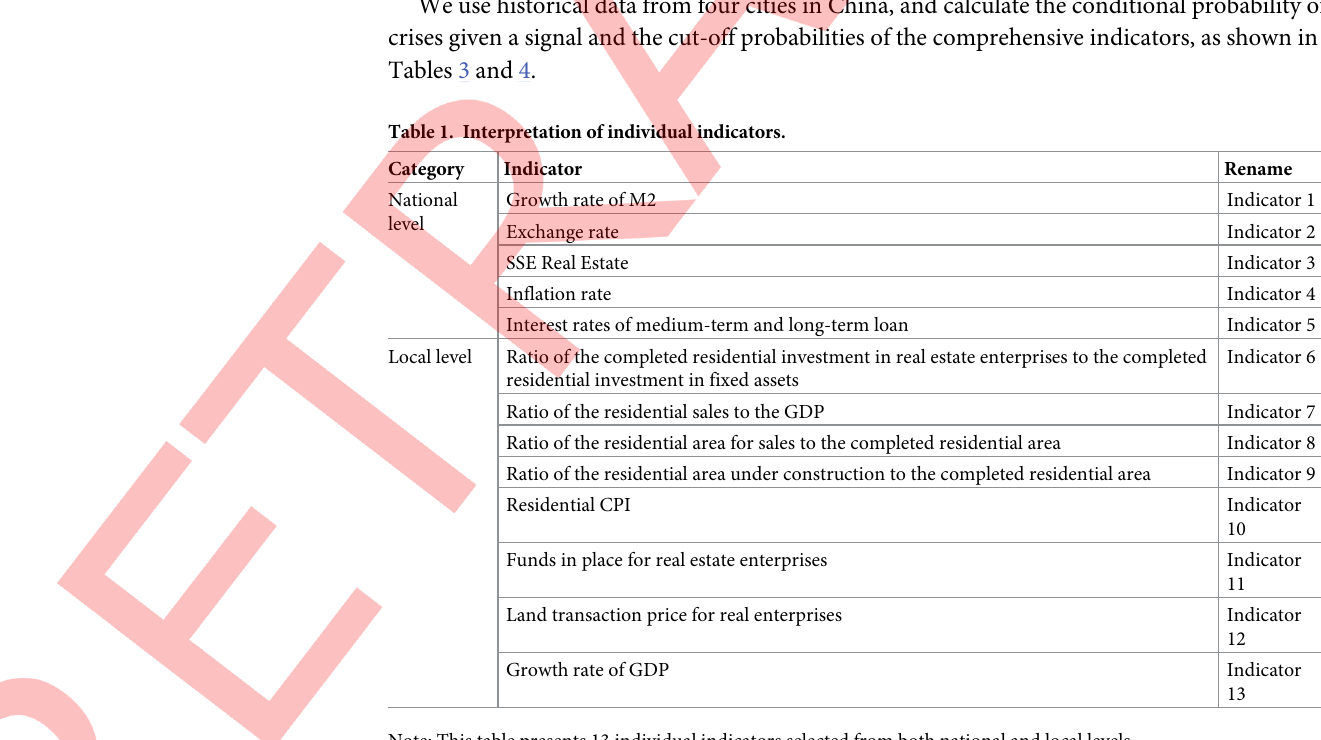
Table 1. Interpretation of individual